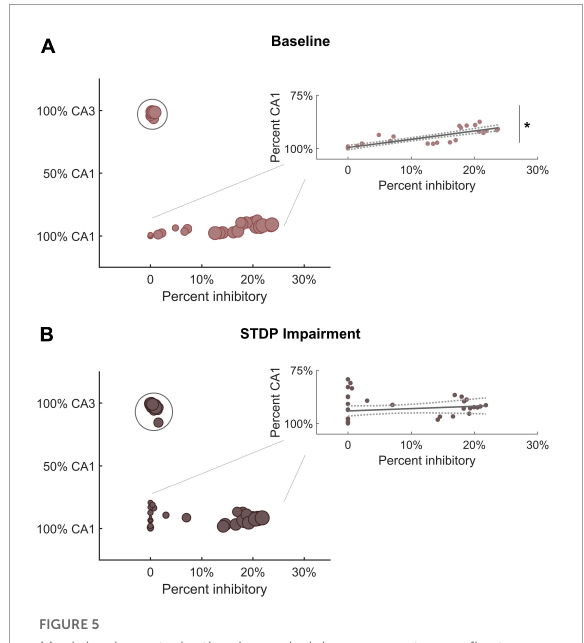
FIGURE5 Module characterization by underlying neuron type reflect hippocampal anatomy. (A) At baseline, one subgroup of modules is comprised primarily of CA3 excitatory neurons (within circle). Predominantly CA1 modules contain most of the inhibitory neurons from both CA3 and CA1. Therefore, there is a significant relationship between the percentage of inhibitory neurons and the percentage of CA1 neurons in these modules (inset) ( R 2 = 0.75; linear hypothesis test; p < 1e-5). As the percentage of inhibitory neurons increases, the percentage of CA1 neurons decreases (inset). (B) After STDP impairment, there remains a subgroup of modules comprised of CA3 excitatory neurons (within circle). However, a new subgroup of small modules develops. These are made up of excitatory neurons from both CA1 and CA3. The appearance of these small excitatory modules eliminates the relationship between inhibitory tone and the percentage of CA1 neurons (inset) ( R 2 = 0.03; linear hypothesis test; p > 0.1). * p <